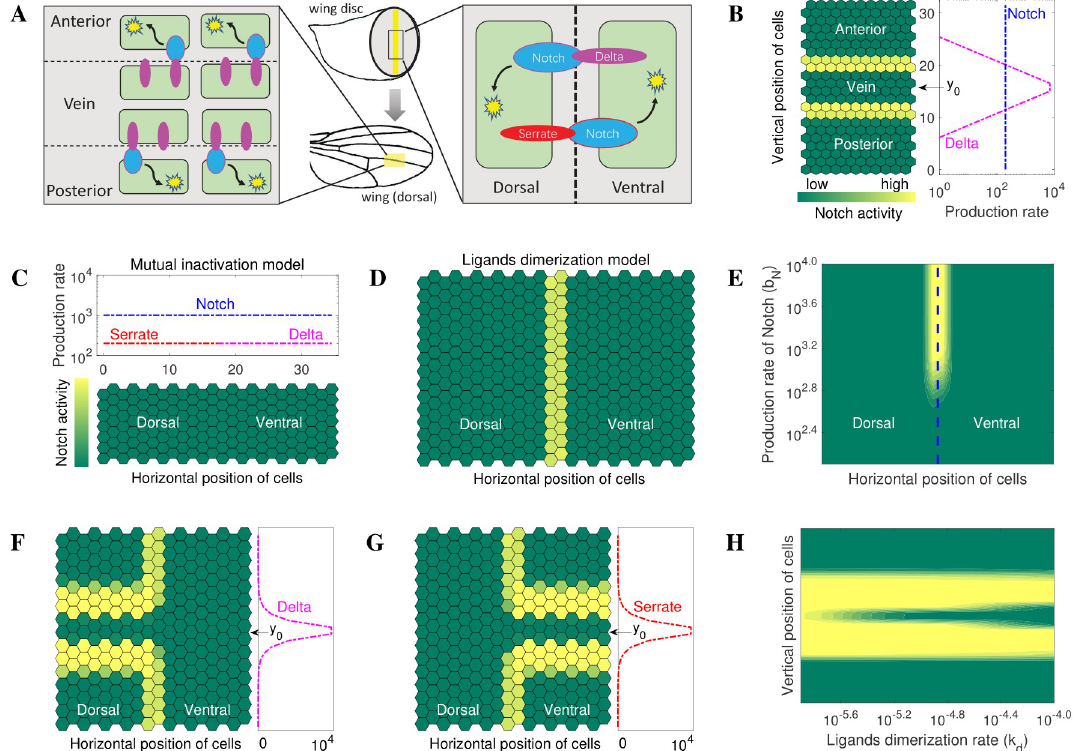
Fig 9. Modelling multicellular patterning. (A) Schematic representation of Notch signalling along the wing vein and along the dorsoventral boundary of the wing disc. Blue ovals represent Notch. Red ovals represent serrate. Purple ovals represent Delta. Notch activity is shown by yellow stars. (B) In silico replication of Notch signalling along the wing vein (for movie of the simulation, see S1 Video). The production rates of Delta decay exponentially from the center y 0 , according to b ( y ) = L /exp(| y − y 0 |). (C-H) In silico L max replication of Notch signalling around the dorsoventral boundary (for movie of the simulation, see S2 Video). (C-D) The ligand dimerization model, but not the mutual inactivation model, replicates the observed in vivo pattern of Notch signalling along the dorsal-ventral boundary in Drosophila wing discs. (E) Notch signalling at the dorsal-ventral boundary for different production rates of Notch show loss of the dorsal-ventral boundary as a function of decreasing Notch production rate, consistent with the results of in vivo experiments [45, 46]. (F-G) Ectopic expression of ligands induces Notch activity in dorsal cells (mediated by Delta) or ventral cells (mediated by Serrate) adjacent to the ectopic expression stripe where the production rates of ectopic ligands decay exponentially from the center y 0 , similar to the profile described in B. (H) High production rates of Notch ligands stimulates ectopic Notch receptor activity when the ligands dimerization rate is low, consistent with previously published experimental data